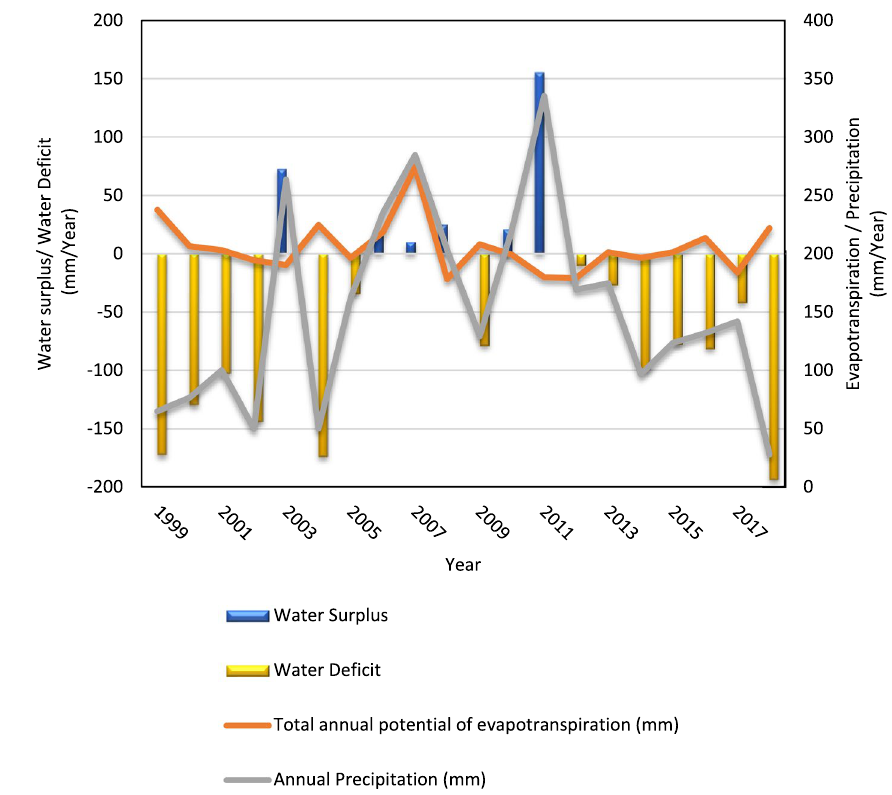
Fig. 18 Water surplus/water deficit compares with evapo- transpiration and